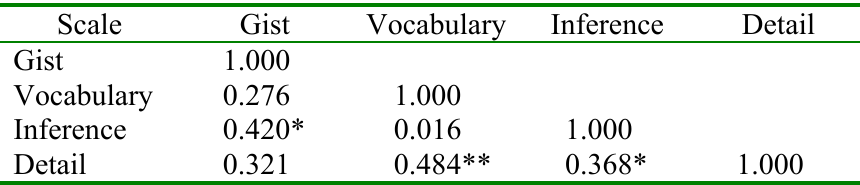
Correlation Matrix for the Reading Test ( K =12, N =29) Scale Gist Vocabulary Inference Detail Gist 1.000 Vocabulary 0.276 1.000 Inference 0.420* 0.016 1.000 Detail 0.321 0.484** 0.368*